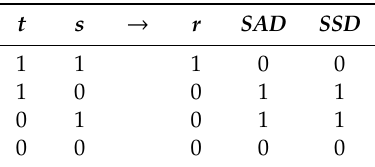
Table 2. Correlation r , Sum of Absolute Di ff erences (SAD) and Sum of Squared Di ff erences (SSD) comparison for binary